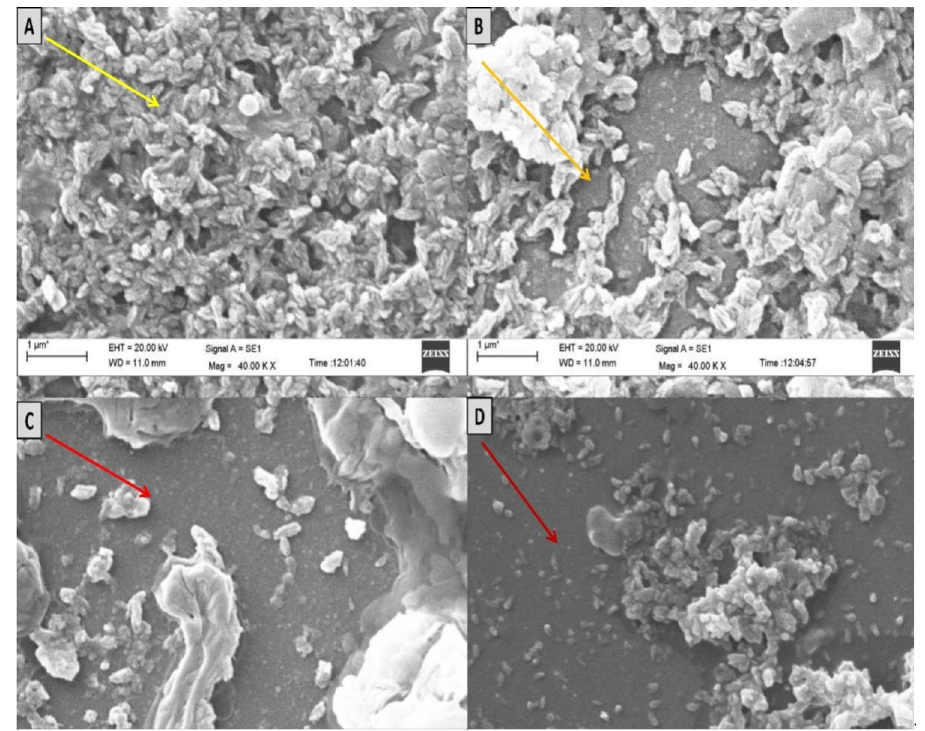
Figure 4. Mode of action of peoriaerin IBSD35 against S. aureus ATCC 25923 and imaging with scanning electron microscopy. The morphological changes of S. aureus ATCC 25923 when treated with peoriaerin IBSD35 1× MIC at different experimental conditions. ( A ) S. aureus ATCC 25923 only, ( B ) S. aureus ATCC 25923 with peoriaerin IBSD35 at 0 h, ( C ) S. aureus ATCC 25923 with peoriaerin IBSD35 at 1 h, ( D ) S. aureus ATCC 25923 with peoriaerin IBSD35 at 2 h. The yellow arrows point to S. aureus ATCC 25923 colonies without peoriaerin IBSD35 and at zero hours with peoriaerin IBSD35. The red arrow points to the disappearance of S. aureus ATCC 25923 at 1 and 2